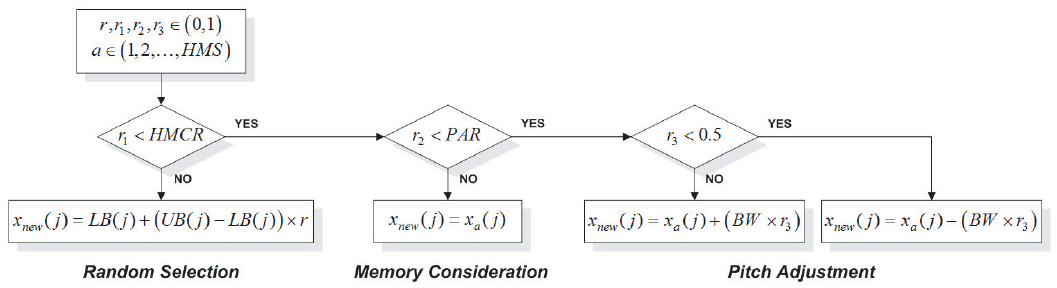
Figure 7. Improvisation process of a new harmony vector in Harmony Search (HS) algorithm.